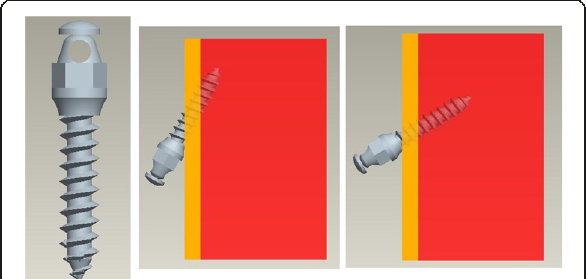
Fig. 1 Three-dimensional solid model of the mini-implant and bone: three-dimensional solid model of a 35-mm section of the alveolar bone of the posterior maxilla with a single self-drilling titanium mini-implant with a small head-type and tapered screw. Cortical layer of the bone depicted in orange and the cancellous bone in red